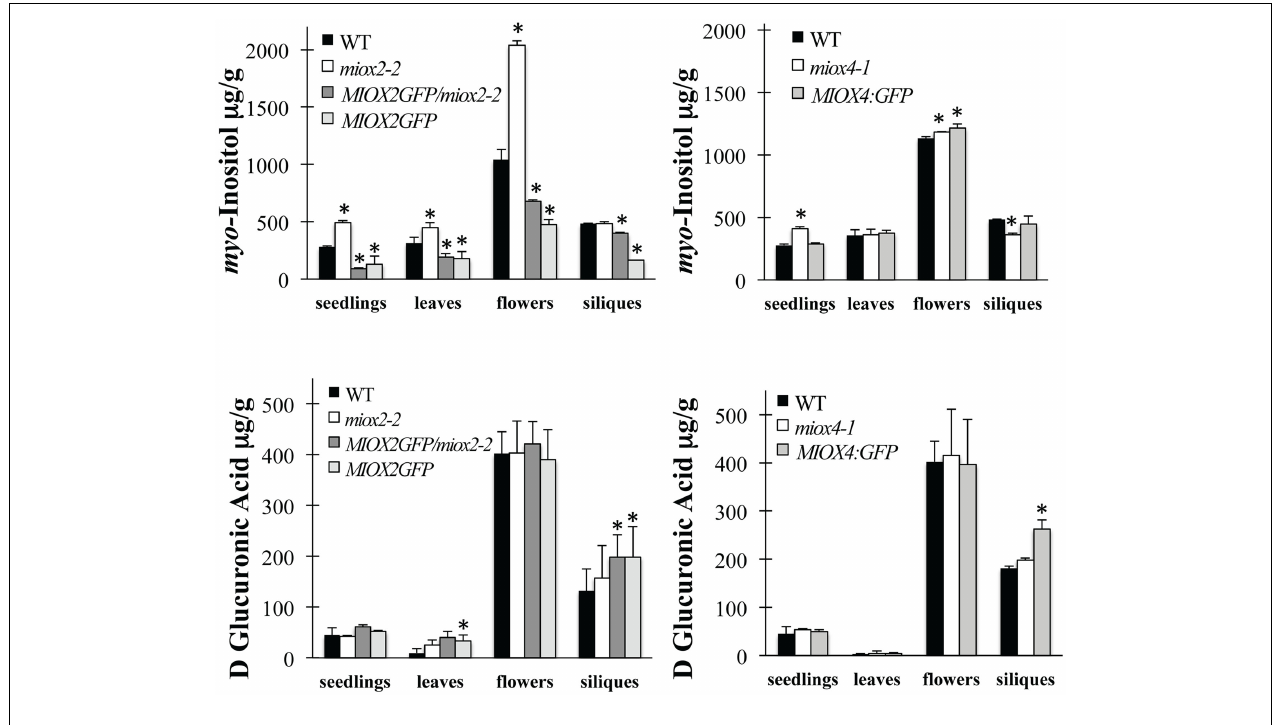
Bars represent the mean ± SD where n = 3–5 independent, biological replicates, with each seedling replicate containing hundreds of 5-day-old low nutrient-grown seedlings, each leaf replicate containing three to five 6-week-old leaves, each flower replicate containing 50–100 open flowers, and each silique replicate containing 30–50 green, elongated siliques. *Indicates p -value ≤ 0.05 as compared